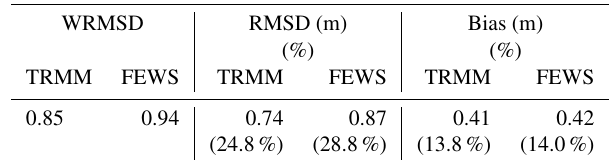
Table 7. Basin amplitude statistics at all virtual stations: bias and root mean square deviation (RMSD). The percentages are relative to the mean observed